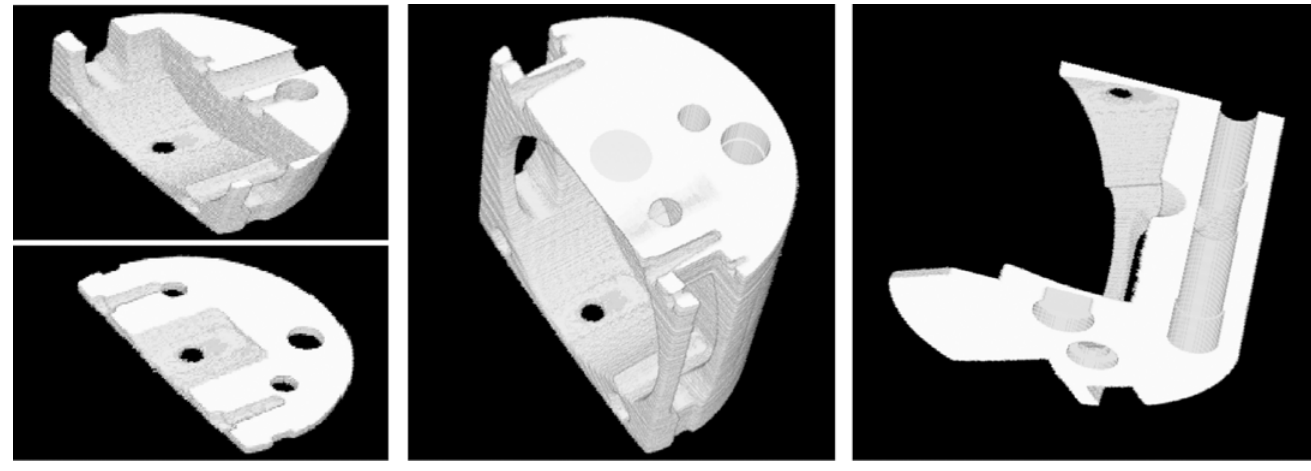
Fig 12. 3D sections viewed from various axes.